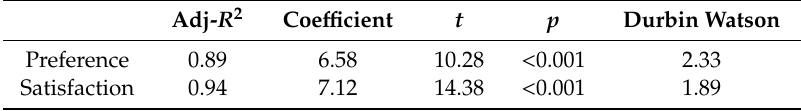
Figure 9. Scatter plot of preference and satisfaction with cookie box density (the black dot is the first experiment, and the white dot is the second experiment). Table 12. Preference and satisfaction regression model with cookie box